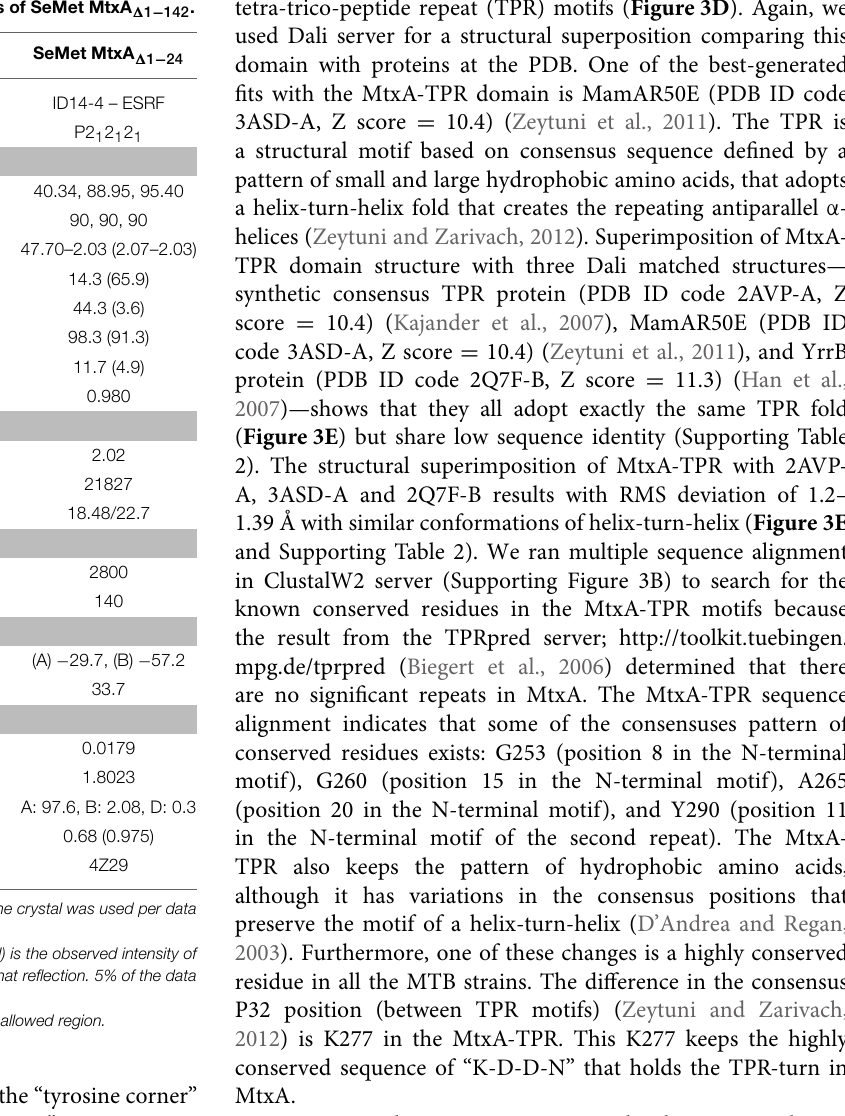
TABLE 1 | Data collection and refinement statistics of SeMet MtxA 1 1 − 142